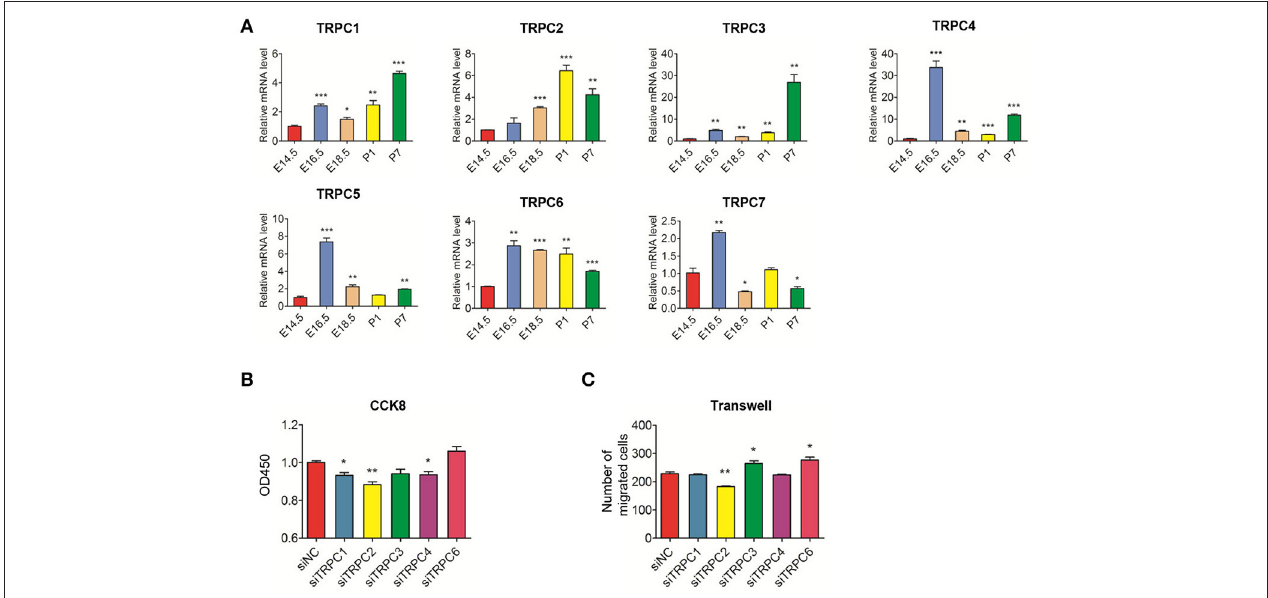
FIGURE 3 | Real-time PCR analysis of TRPC channels mRNA expression in the development stages of rat tooth germs (E14.5–P7) and the effect of knockdown TRPC genes on proliferation and migration of rat DPSCs (A) Changes in mRNA levels of TRPC channels during tooth development. Compared with expression at E14.5 stage, the differential expression levels of TRPC channels at E16.5, E18.5, P,1 and P7 stages were evaluated. Data are shown as the mean ± SD; n = 3.* p < 0.05, *** p < 0.001(Student’s t -test). (B) DPSCs were treated with siNC and siTRPC for 96 h and assayed by CCK8. (C) DPSCs were treated with siNC and siTRPC for 48 h, then the transwell assay was performed. The treated siNC DPSCs was used as a negative control group. The number of migrated cells was displayed as histogram. The data were displayed as the mean value of cells in five fields from three independent experiments. Results are expressed as the mean ± SD of three independent experiments. * p < 0.05, ** p <